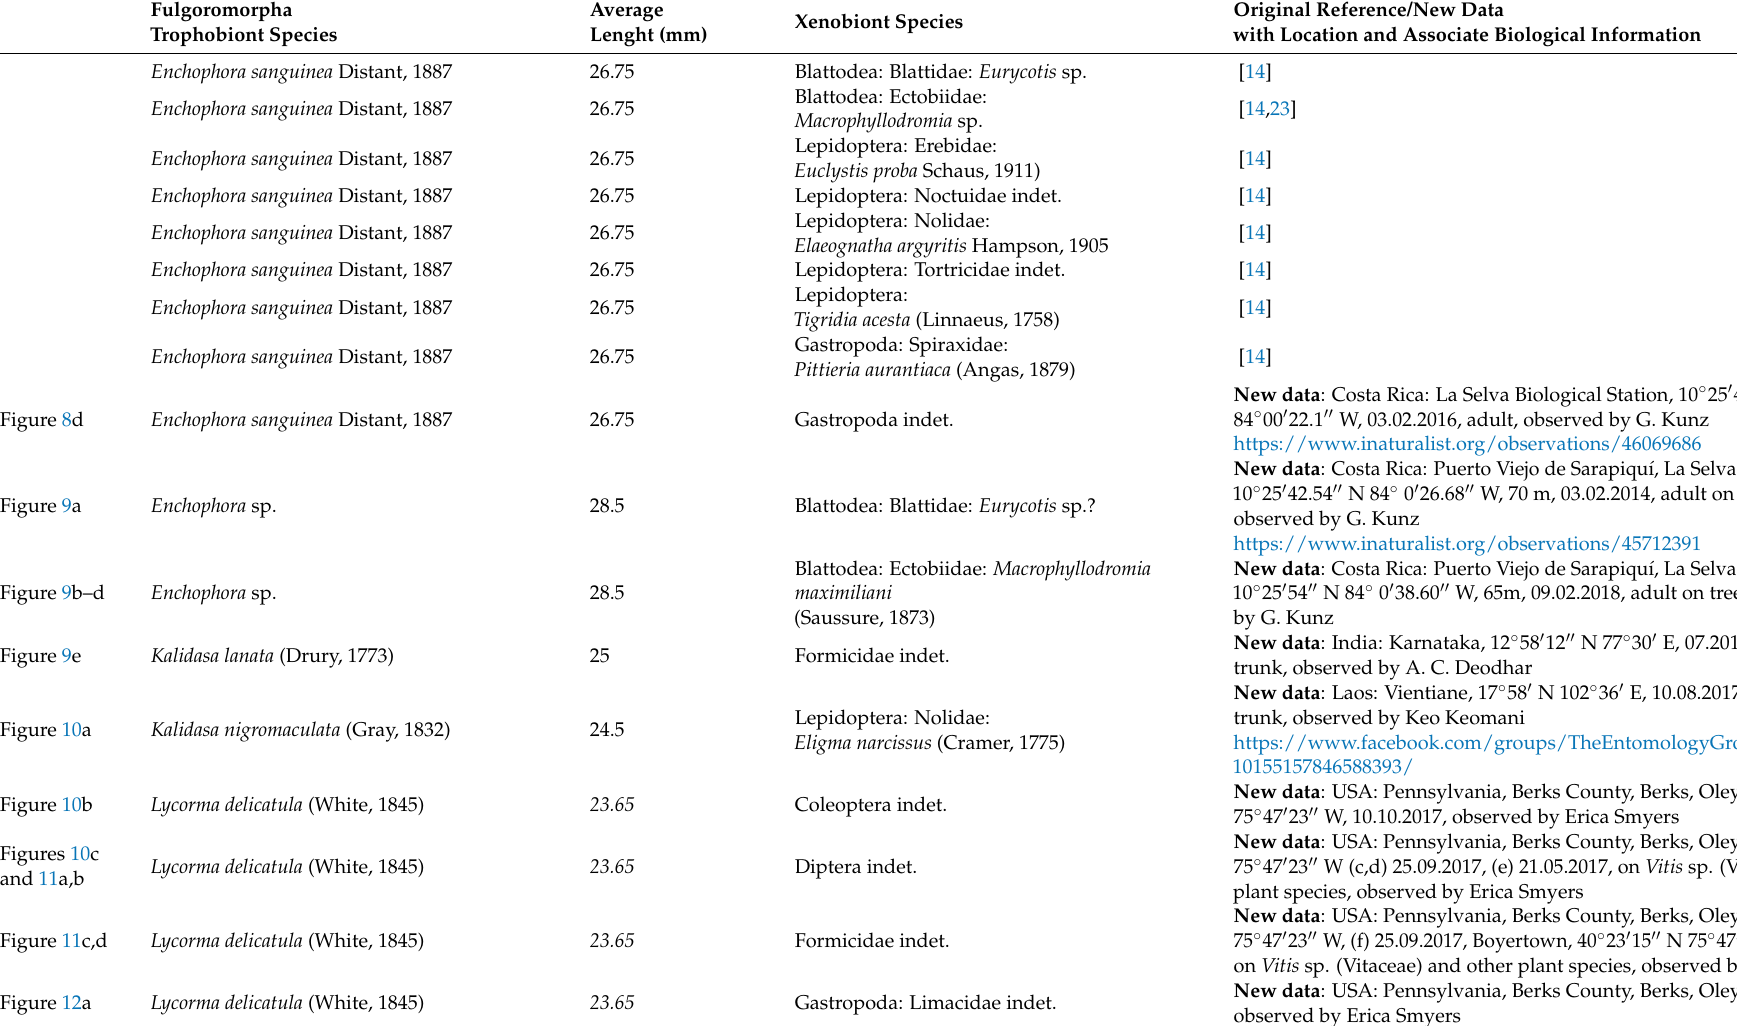
23.65 Formicidae indet. 23.65 Gastropoda: Limacidae